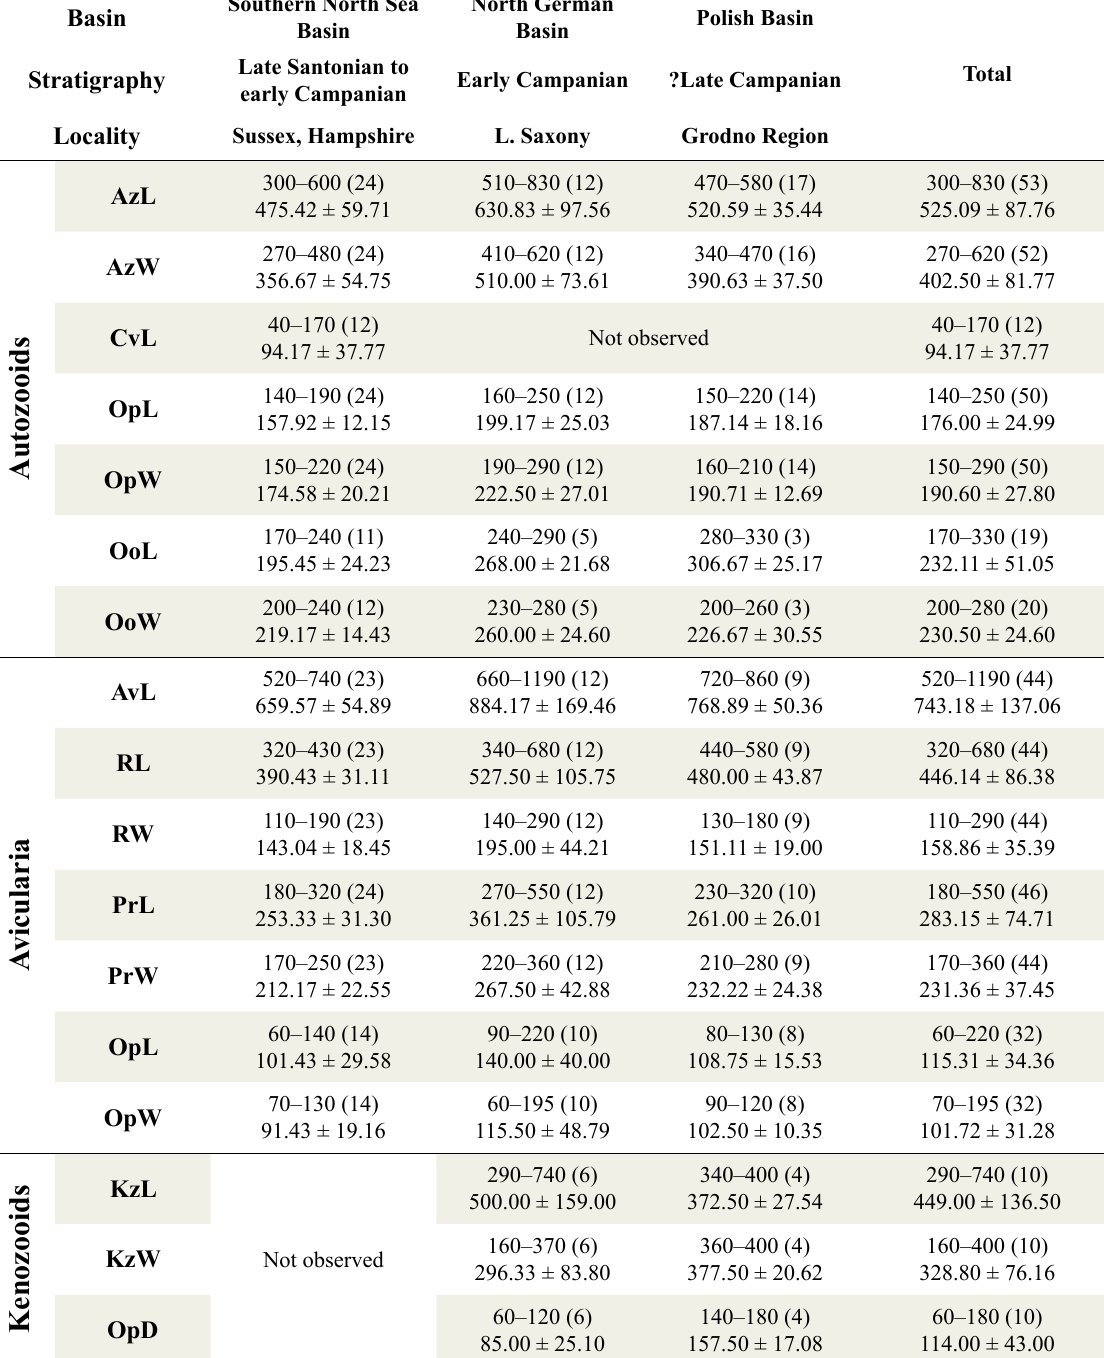
Table 1. Summary of measurements of Rhagasostoma inelegans (Lonsdale, 1850). For each parameter the range is given with the number of measurements in brackets. The arithmetic mean is given ± standard deviation. All measurements in